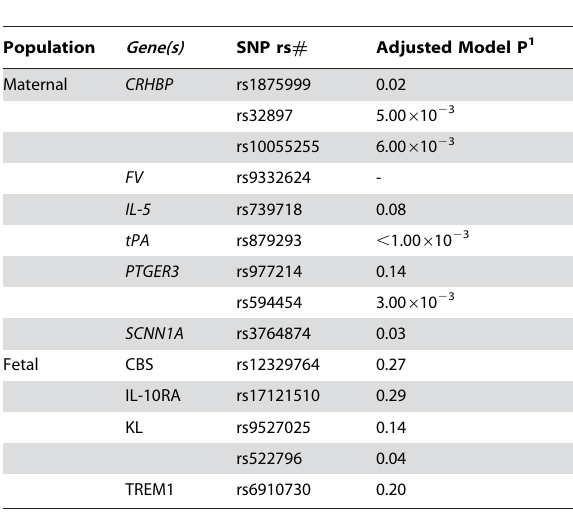
Table 5 . Single locus association genotypic logistic regression analyses adjusted for smoking and gravidity